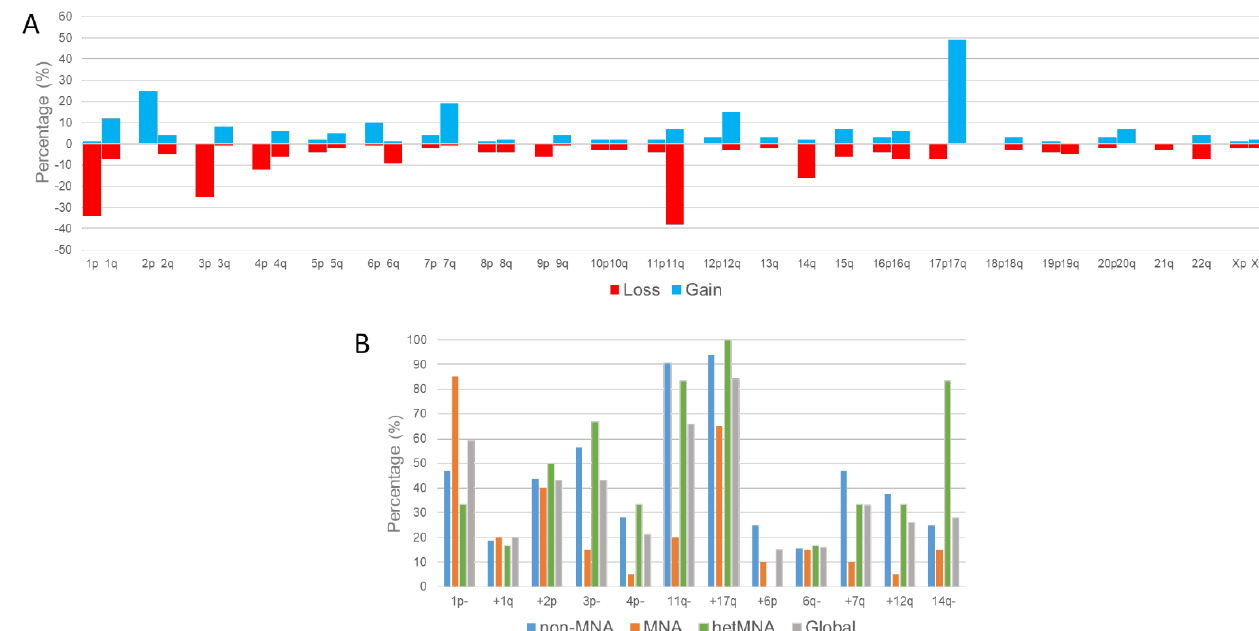
Figure 4. Percentage of the analysed cases that showed ( A ) segmental chromosomal aberrations in each chromosome arm (losses of genomic material are in red, and gains in blue). ( B ) Percentage of each segmental chromosome aberration observed in the cases MYCN non-amplified (non-MNA, blue), MYCN amplified (MNA, orange) or with heterogeneous amplification of MYCN (hetMNA, green), and in all the analyzed high-risk neuroblastoma cases (grey).